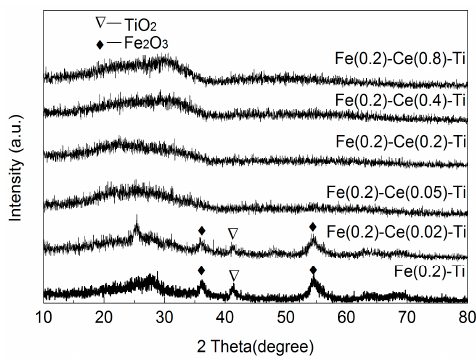
Figure 5. XRD patterns of Fe(0.2)–Ce( x )–Ti catalysts ( x = 0, 0.02, 0.05, 0.2, 0.4, 0.8).